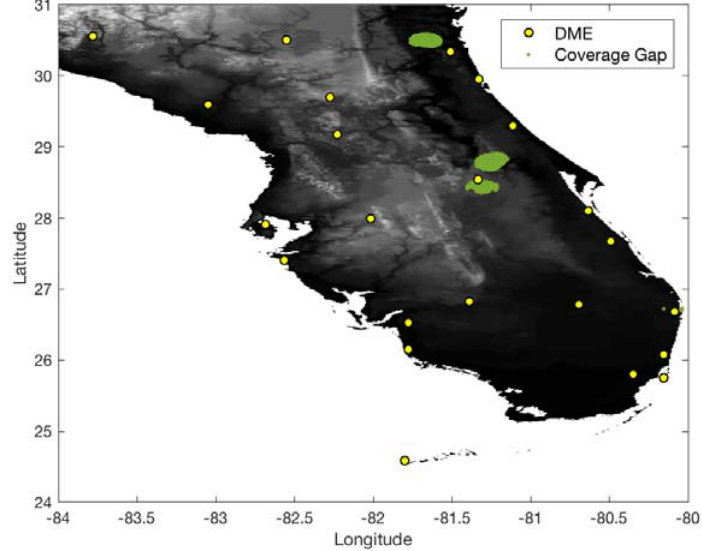
Figure 9. DME/DME positioning accuracy gaps of 0.3 nm with DME/S and the current DME ground network.